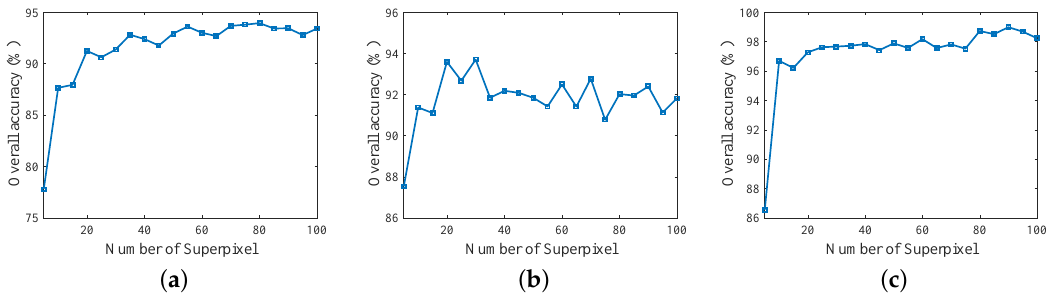
Figure 7. Overall accuracy of the proposed method with different numbers of superpixels: ( a ) Indian Pines; ( b ) University of Pavia; and ( c ) Salinas